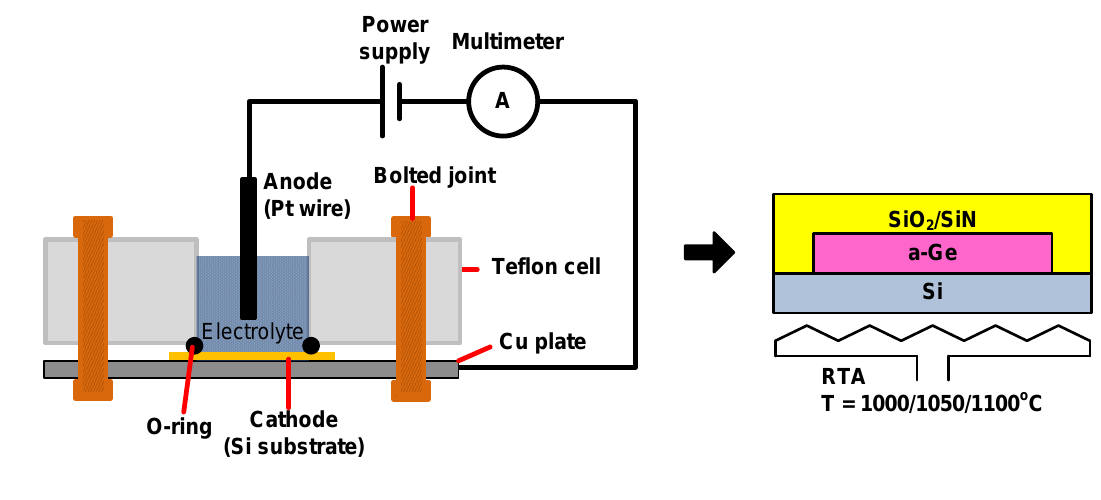
Figure 1. Schematic representations of electrochemical deposition setup and rapid melting process.